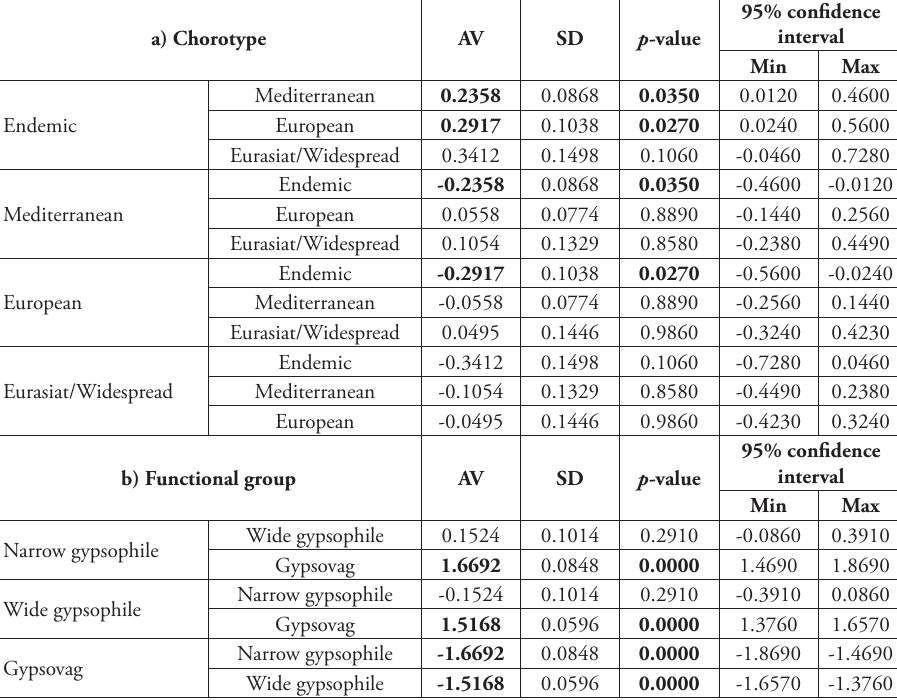
Table 5. ANOVA analysis by gypsophily level. Average (AV). Standard deviation (SD). 5a) Grouping by distribution: Italian endemic, Mediterranean, European and Wide distribution. 5b) Grouping by func- tional group: narrow gypsophile, wide gypsophile and